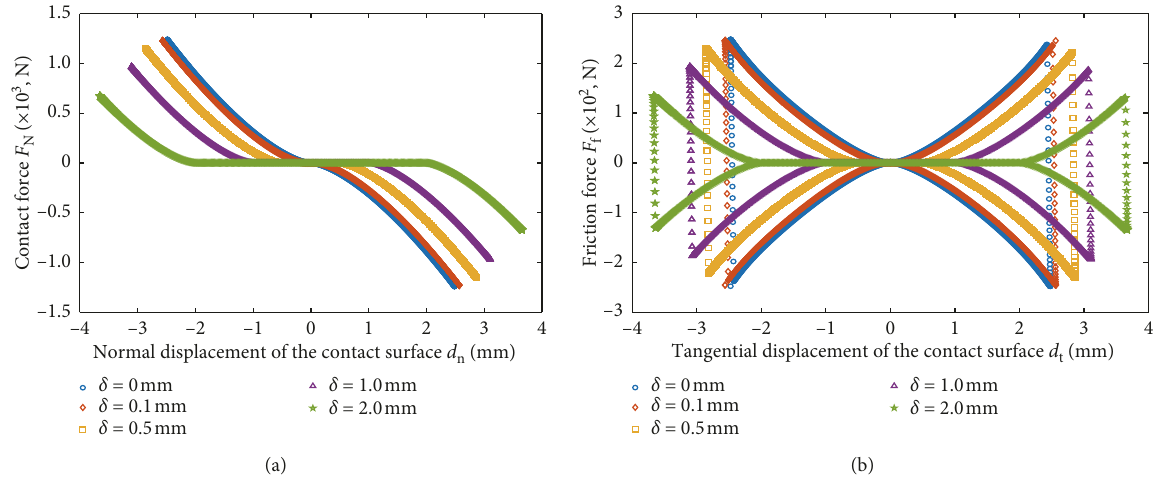
Figure 14: The curves of force at different clearances. (a) Contact forces. (b) Friction